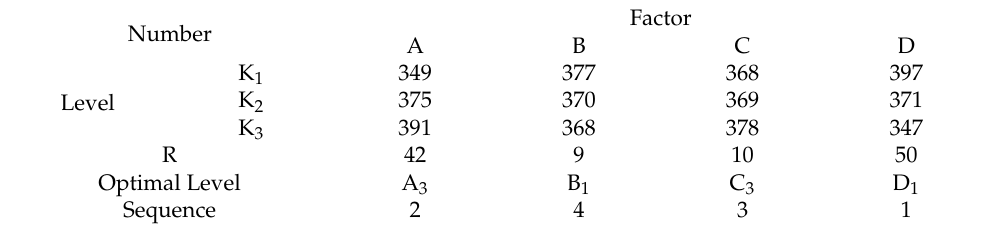
Table 7. Range analysis of orthogonal